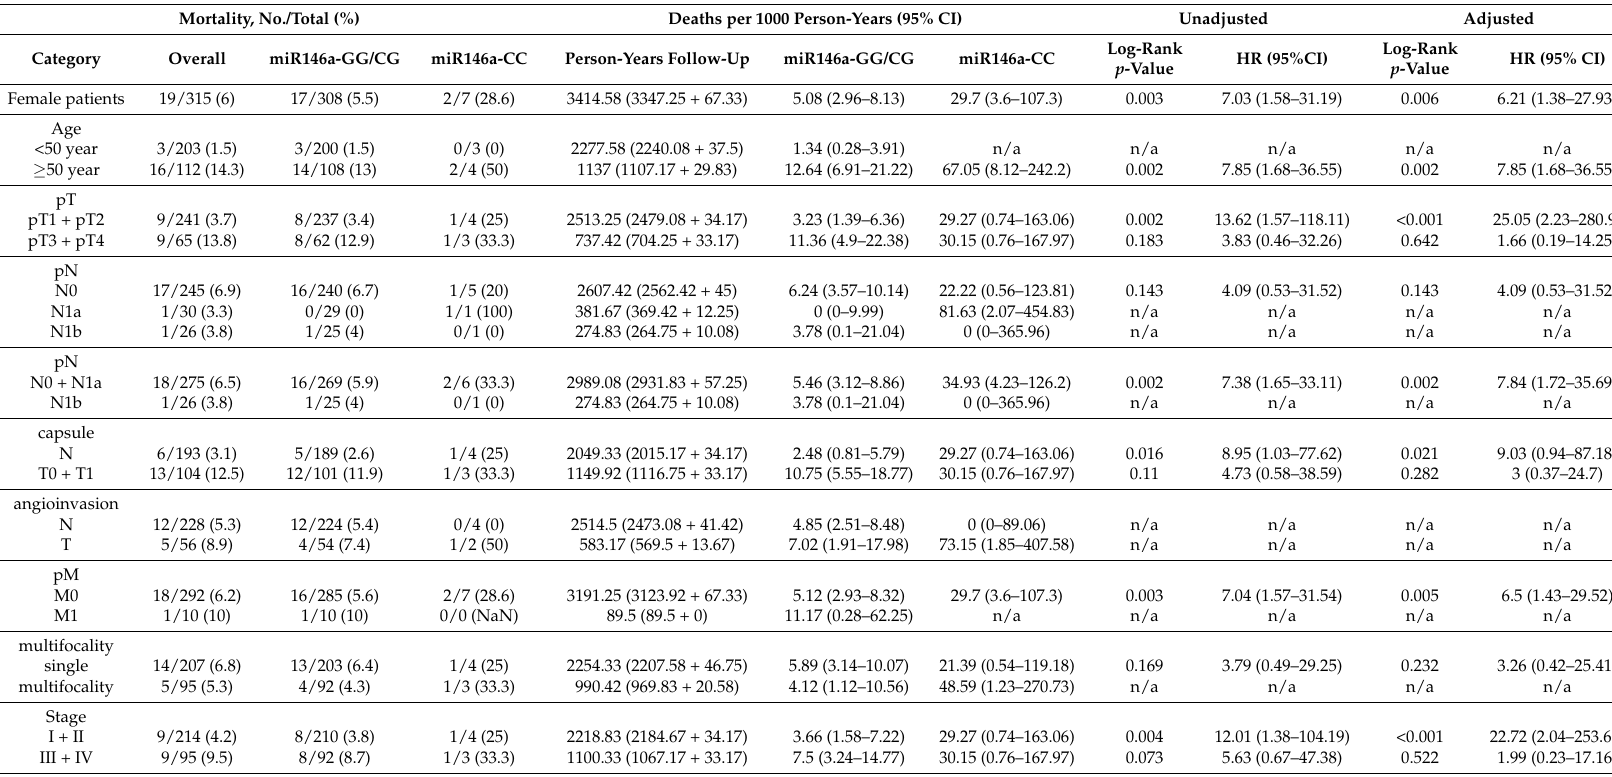
Table 1. The association of rs2910164 with various clinicopathological factors in follicular variant of papillary thyroid carcinoma (fvPTC) patients. n/a –not